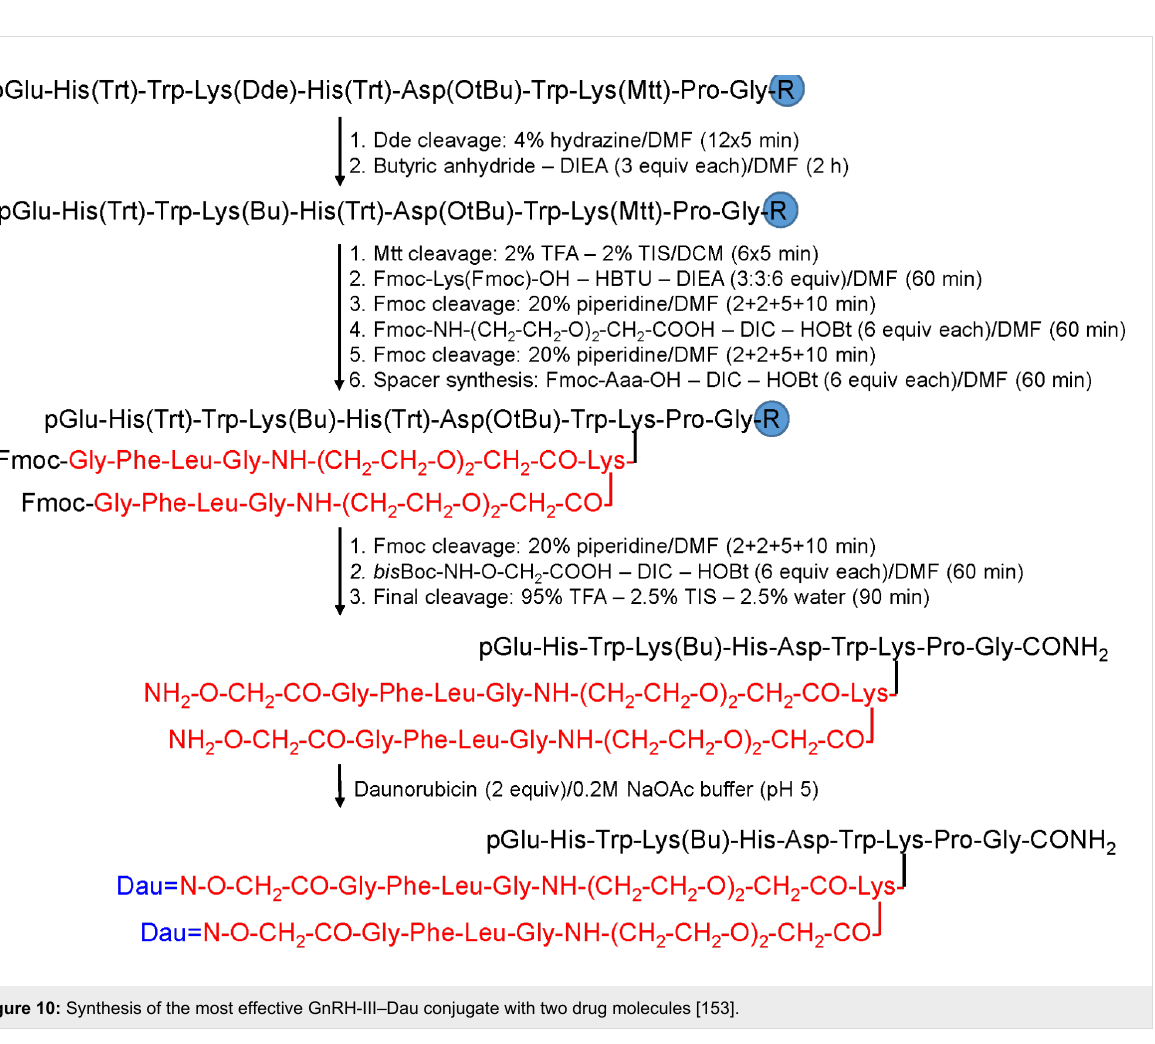
PC-3) and the PDC GSG showed IC50 values similar to gemci- tabine GSG that possessed the highest antiproliferative effect was utilized for further pharmacokinetic studies in mice. These pinpointed that GSG is able to release a high amount of gemci- tabine (averaging 500 ng/mL) for a period of over ≈ 250 min, while administered free gemcitabine was consumed in less than 100 min. At the same time, the levels of the inactive